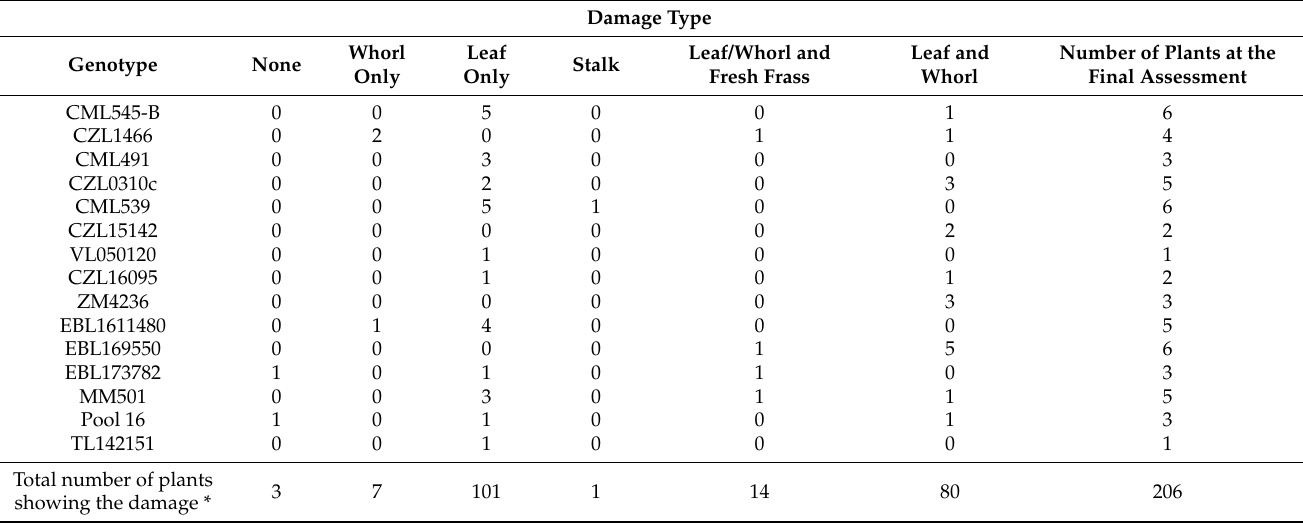
Table 9. FAW damage type and magnitude assessed from 15 representative maize genotypes evalu- ated under artificial FAW